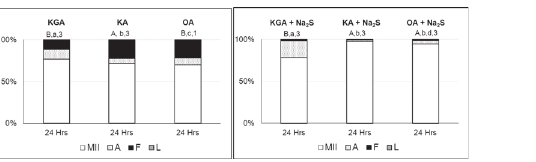
Figure 4. Reversion of the effects of CBS, CSE and MPST inhibitors using a H 2 S donor. Oocytes were cultivated to metaphase II and then exposed to prolonged cultivation (24 hours) in a modified M199 medium supplemented with a H 2 S donor (Na 2 S.9H 2 O; 300 μ M) and the following individual inhibitors: oxamic acid (1mM, OA), beta-kyano-L-alanine (1mM, KA), and alpha-ketoglutaric acid disodium salt dihydrate (5mM, KGA). Na 2 S (300 μ M, Na 2 S.9H 2 O); KGA — alpha-ketoglutaric acid disodium salt dihydrate (5 mM); KA – beta- kyano-L-alanine (1mM); OA — oxamic acid (1 mM); MII — intact oocytes (oocytes at metaphase II, anaphase II or telophase II), A — activated oocytes (oocytes with pronuclei or embryos), F — fragmented oocytes, L — lysed oocytes; Different letters and numbers indicate significant differences between different treatments